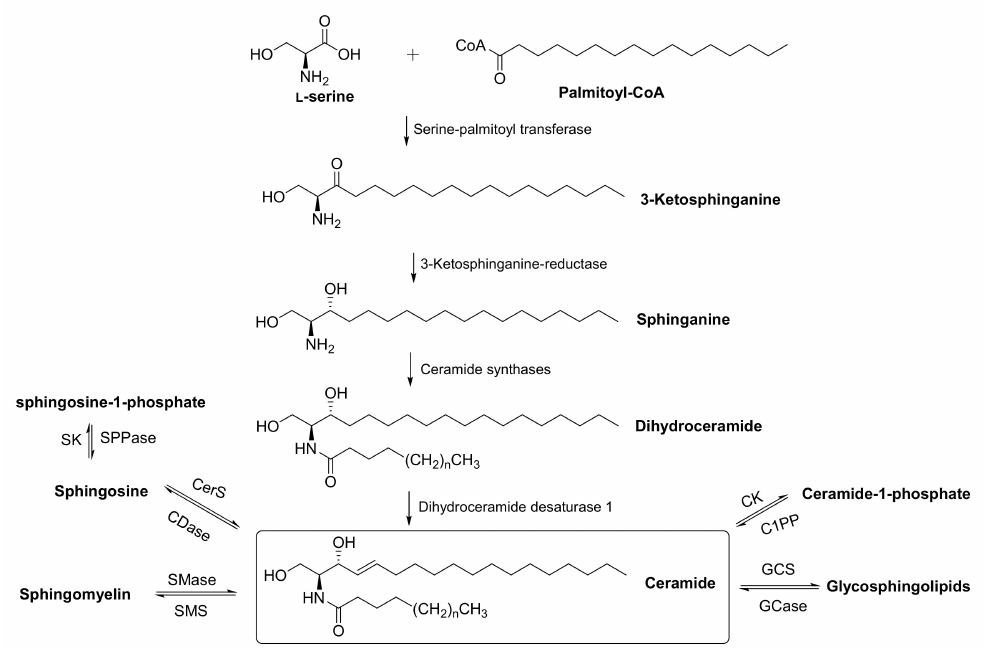
Figure 1. Metabolism of canonical sphingolipids. Various different headgroups can be added to ceramide to form different classes of complex sphingolipids. SMS, sphingomyelin synthase; SMase, sphingomyelinase; GCS, glucosyl-ceramide synthase; GCase, glucosyl ceramidase; CDase, ceramidase; CerS, ceramide synthase; CK, ceramide kinase; C1PP, ceramide-1-phosphate phosphatase; SPPase, S1P phosphatase; SK, sphingosine